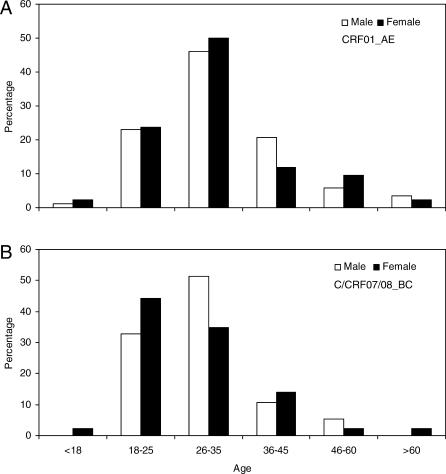
Two Major HIV-1 Subtypes among Different Age and Gender Groups in YunnanThe upper panel represents subtype CRF01_AE (A), whereas the lower panel is for C/CRF07_BC/CRF08_BC (B). The y-axis indicates the percentage of HIV-1 infection in each age and gender group. There were significantly more females at age 18–25 infected by C/CRF07_BC/CRF08_BC than by CRF01_AE viruses (p < 0.05).